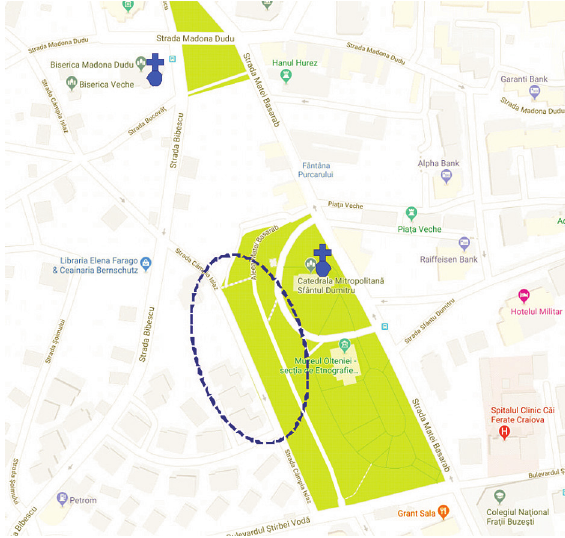
Fig. 4b. location of the 7 Fountains in the central area of the city (Google